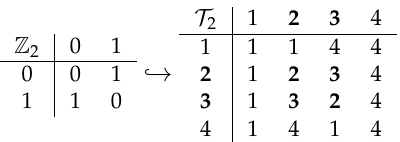
Figure 2. The maps 0 (cid:55)→ 2, 1 (cid:55)→ 3 define an embedding (an isomorphism to a subsemigroup of the target semigroup) of the cyclic group into the full transformation semigroup, n = 2.